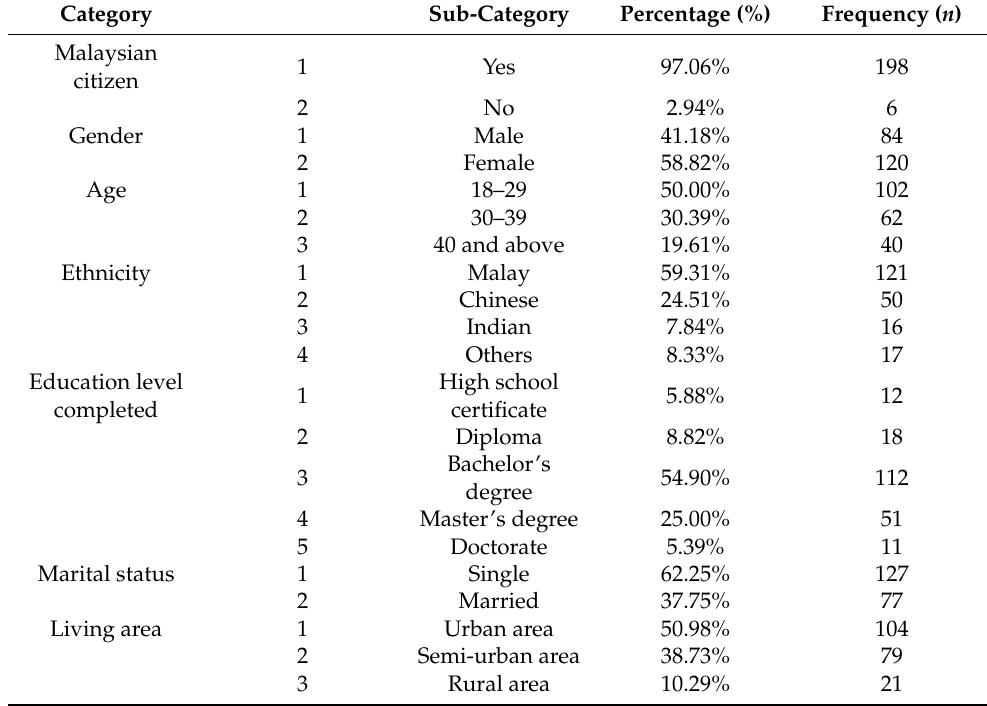
Table 3. Background of